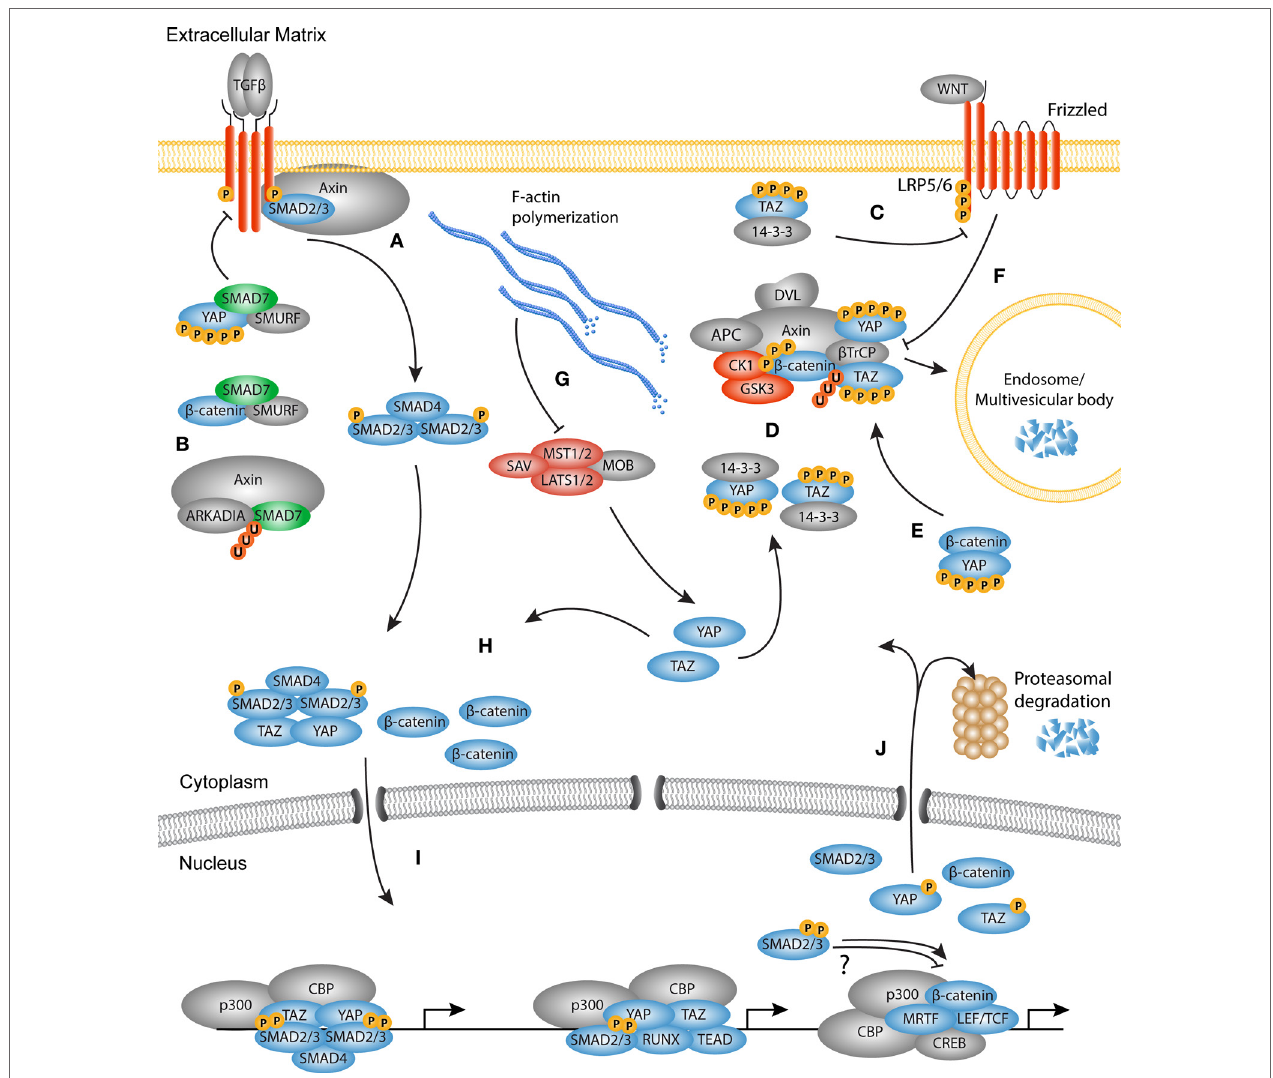
FiGURe 4 | The TGF- β , wNT, and YAP/TAZ signaling pathways converge . Schematic overview of the molecular cross-talk between components of the TGF β , WNT, and YAP/TAZ pathways. (A) Upon TGF- β stimulation, Axin promotes the tail-phosphorylation of Smad3. (B) Axin also promotes the degradation of inhibitory Smad7, thereby further enhancing the TGF- β signal. Smad7 can associate with both YAP and β -catenin. Binding of YAP to Smad7 increases the affinity for the type I receptor and increases the repressive effects on TGF- β signaling. Smad7 binding with β -catenin can mediate both degradation and stabilization of β -catenin. (C) TAZ inhibits the phosphorylation of disheveled (DVL) by casein kinase (CK)1, providing either positive or negative feedback depending on the WNT ligand present. (D) The active Hippo core kinase complex phosphorylates both YAP and TAZ creating a phosphodegron. Phosphorylated YAP and TAZ are either sequestered by 14-3-3 proteins or associate with the β -catenin destruction complex. In the destruction complex, YAP and TAZ are necessary for docking of β -TrCP to the complex.